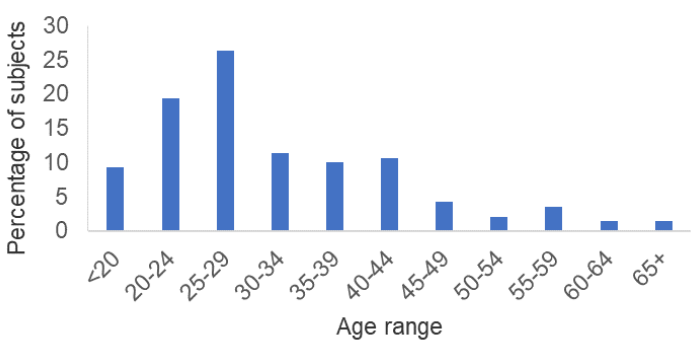
Figure 1. Age range distribution of subjects ( n = 140).